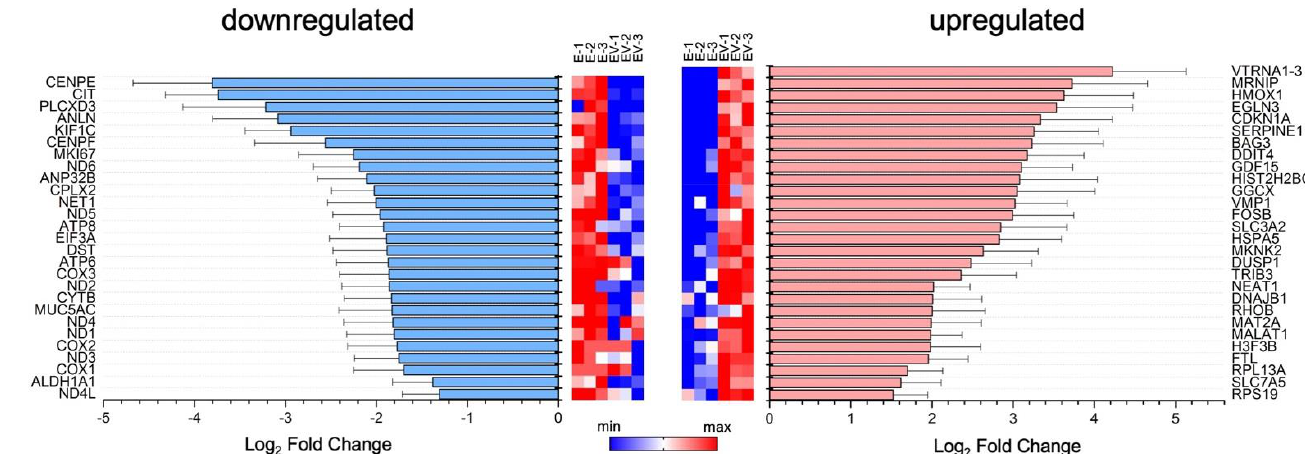
Figure 2. List of mRNAs with different levels between exosomes from infected and mock-infected cells. Significantly downregulated (log 2 fold change < − 1) and upregulated (log 2 fold change > 1) genes are shown. On the left and the right sides of the figure, the names of downregulated and upregulated genes are presented. Heat maps reflect the level of mRNA expression: E-1, E-2 and E-3 — three independent samples of exosomes from mock-infected cells; EV-1, EV-2 and EV-3 — three independent samples of infected-cell-secreted exosomes.